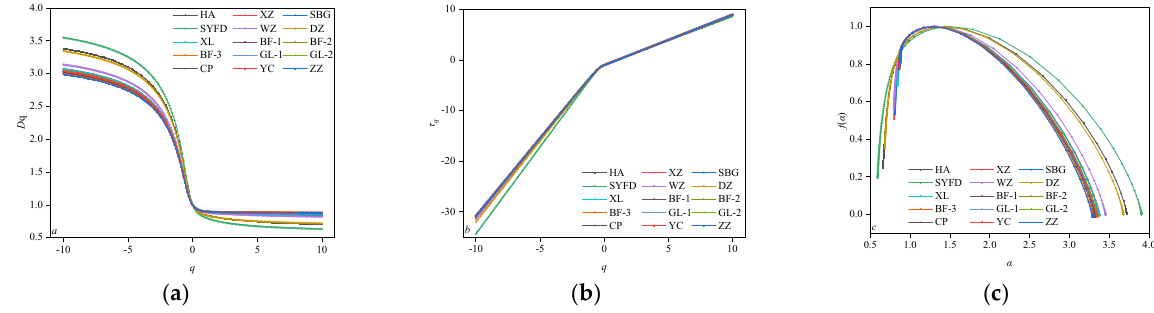
Figure 7. The relationship of multifractal dimension parameters (( a ) Generalized fractal dimension spectrum; ( b ) mass distribution functions τ ( q ) and ( c ) multifractal singular spectrum). Table 2. Multifractal parameters of middle- and high-rank